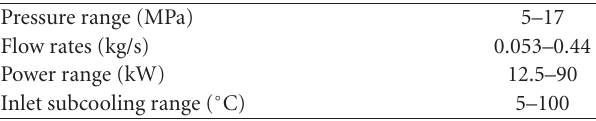
Table 2: Closure